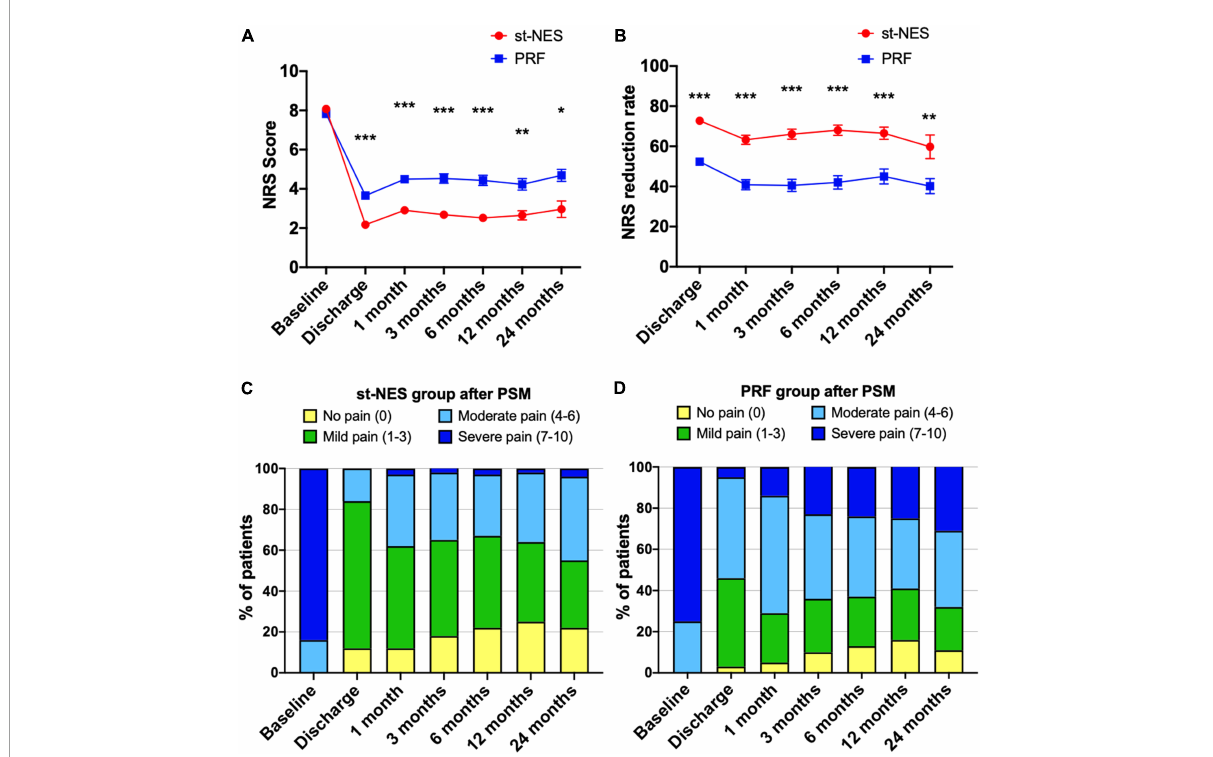
FIGURE2 (A,B) Comparison of the efficacy of the two groups on pain relief after propensity score matching (PSM) by numerical rating scale (NRS) score or NRS reduction rate [ n = 226, * P < 0.05, ** P < 0.01,*** P < 0.001, indicate pulsed radiofrequency (PRF) group vs. short-term nerve electrical stimulation (st-NES) group, P -values for group comparison by Mann–Whitney U -test]. (C,D) Percentage of patients with different pain levels in the st-NES group or PRF